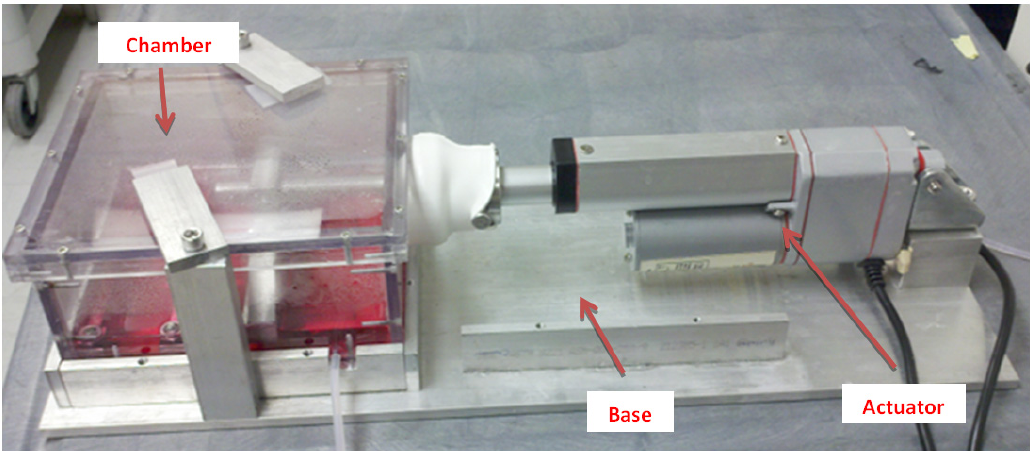
Figure 1. Bioreactor chamber in stretching